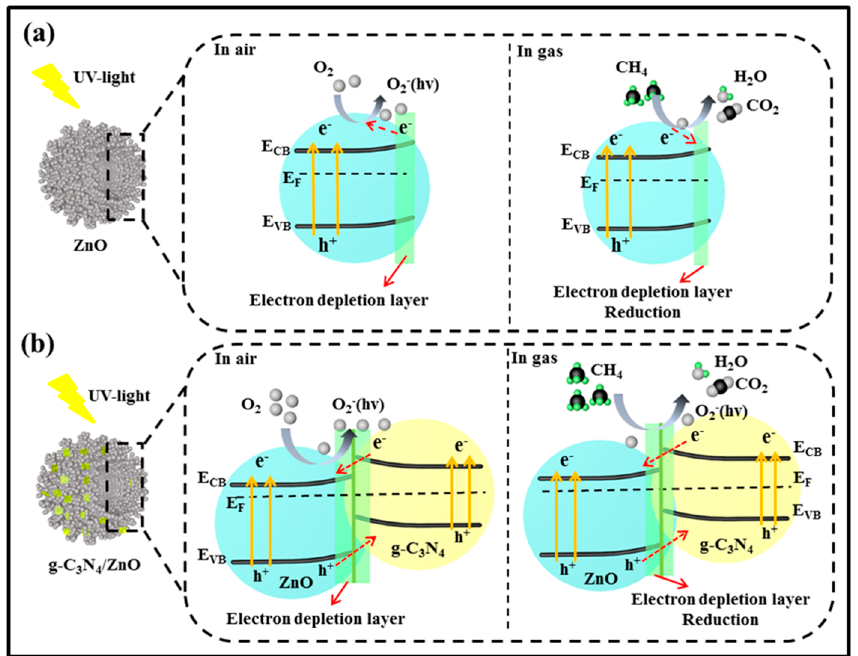
Figure 10. Schematic illustration for the mechanism of photoinduced charge carrier transfers in g-C3N4/ZnO composites under UV irradiation, gas sensing mechanism of ( a ) ZnO and ( b ) g-C 3 N 4 /ZnO.